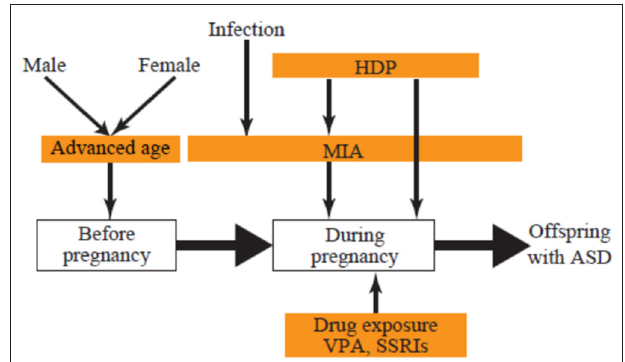
FIGURE 1 | Developmental stage and environmental ASD risks. ASD, autism spectrum disorder; HDP, hypertensive disorders of pregnancy; MIA, maternal immune activation; SSRI, selective serotonin reuptake inhibitor; VPA, valproic